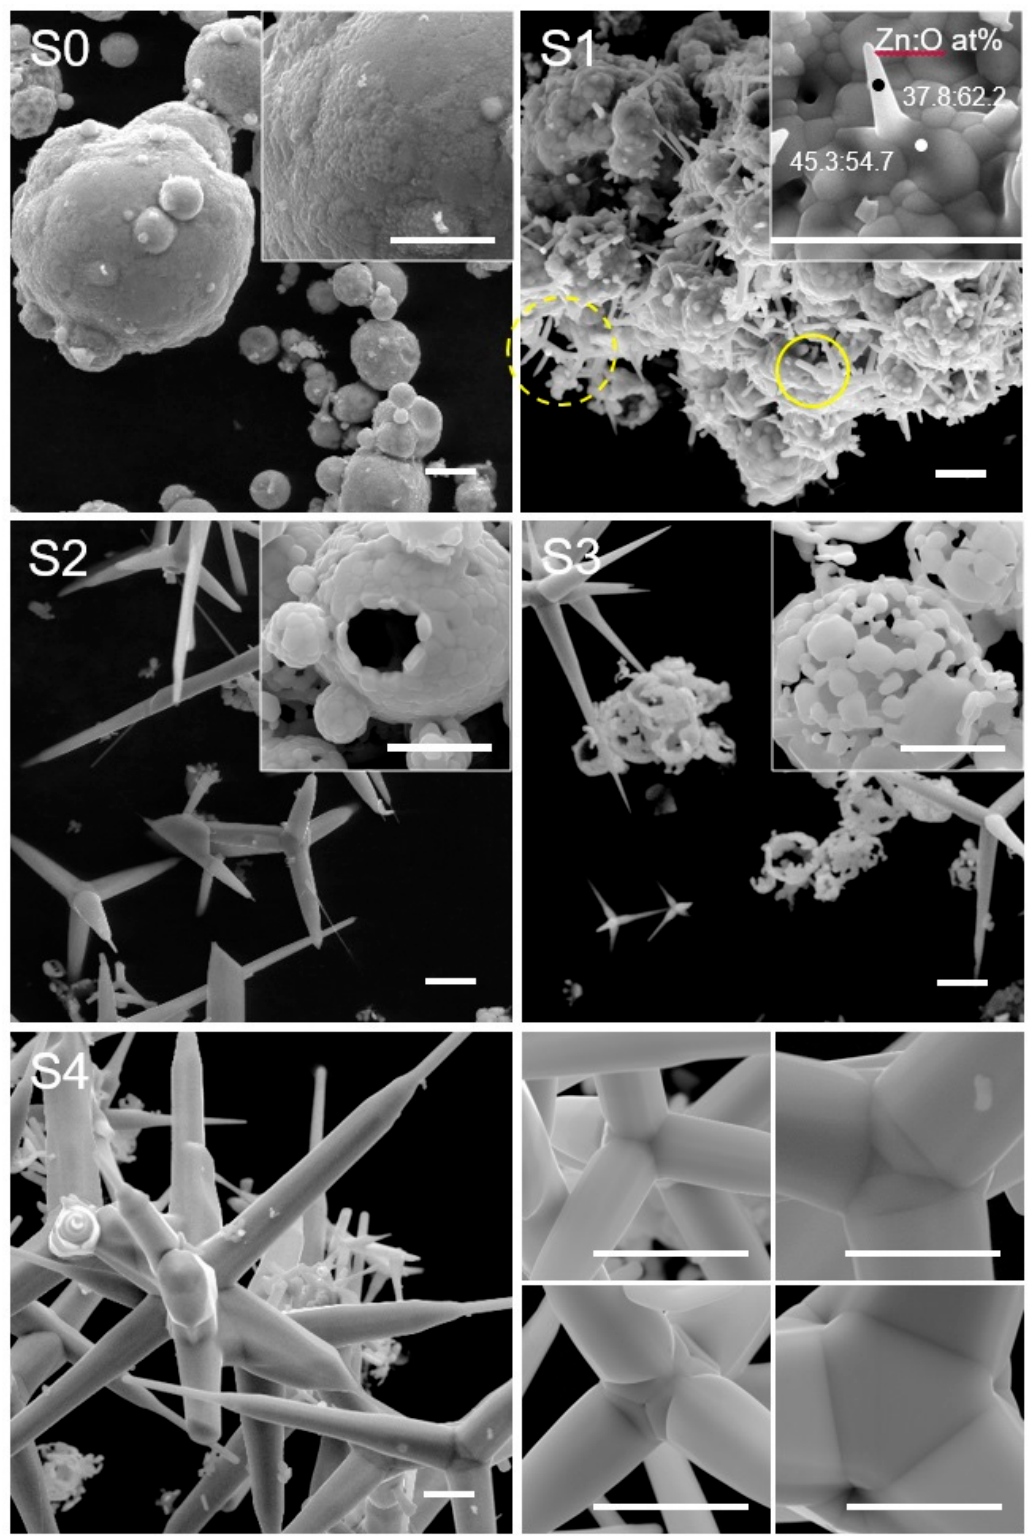
Figure 3. SEM micrographs of the precursor powder (S0) and the products obtained after its thermal oxidation (900 ° C; air atmosphere) during different times: 3 (S1), 6 (S2), 12 (S3), and 24 min (S4). Bottom-right corner: Detail of interleg connections observed in the ZnO tetrapods. All the scale bars correspond to 5 microns.